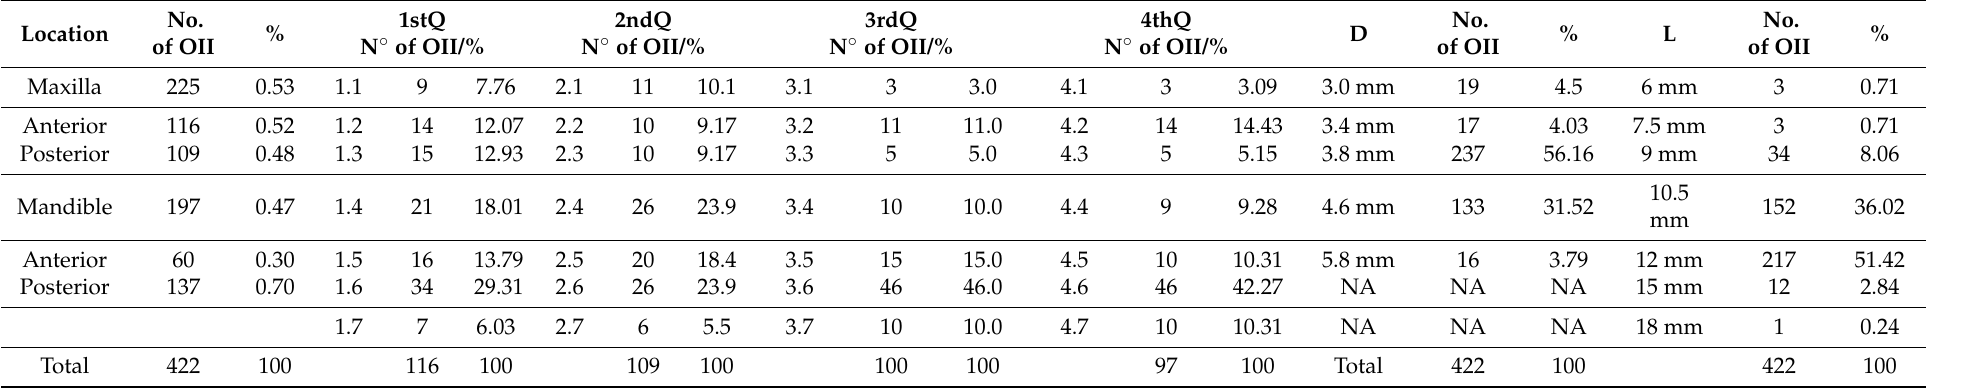
Table 3. Implant distribution by location, diameter, and length. No. of OII: number of osteointegrated implants; Q: quadrant; F: frequency; D: diameter; L: length; OII: osseointegrated implant; NA: not applicable (the diameter and length of the implants were not classified by